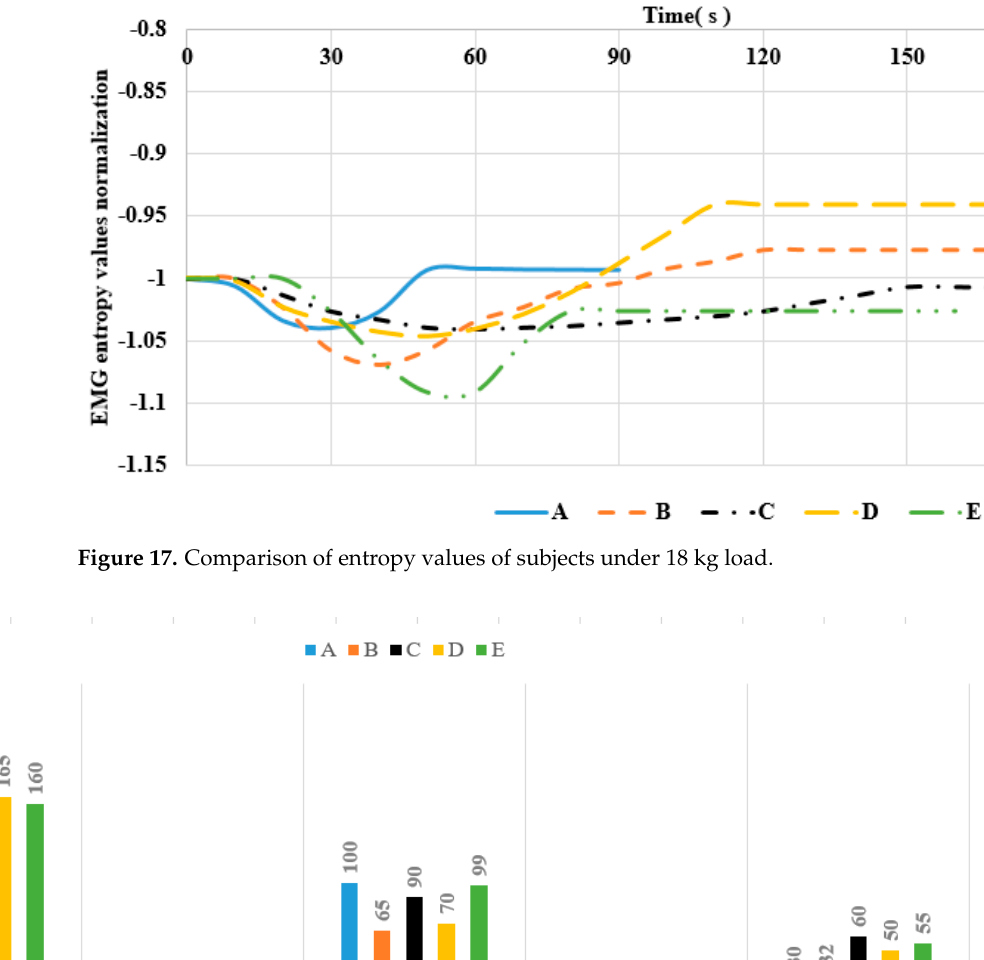
Figure 17. Comparison of entropy values of subjects under 18 kg load.